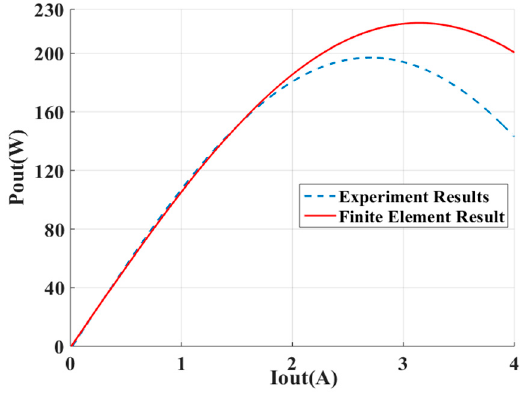
Figure 18. Variation of output power versus load current.